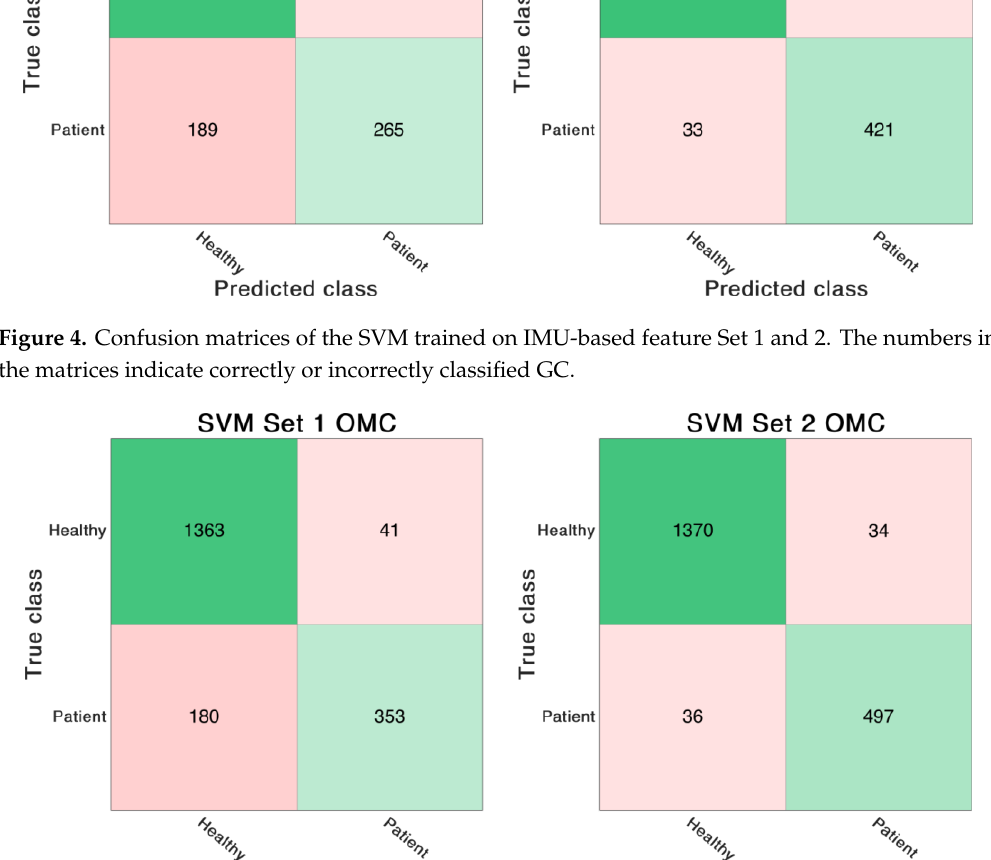
Figure 6. Receiving operating characteristic (ROC) curve for the SVM model trained on IMU-based feature Set 1 and 2. The red dot marks the performance of the corresponding model. The blue area indicates the area under the curve (AUC).